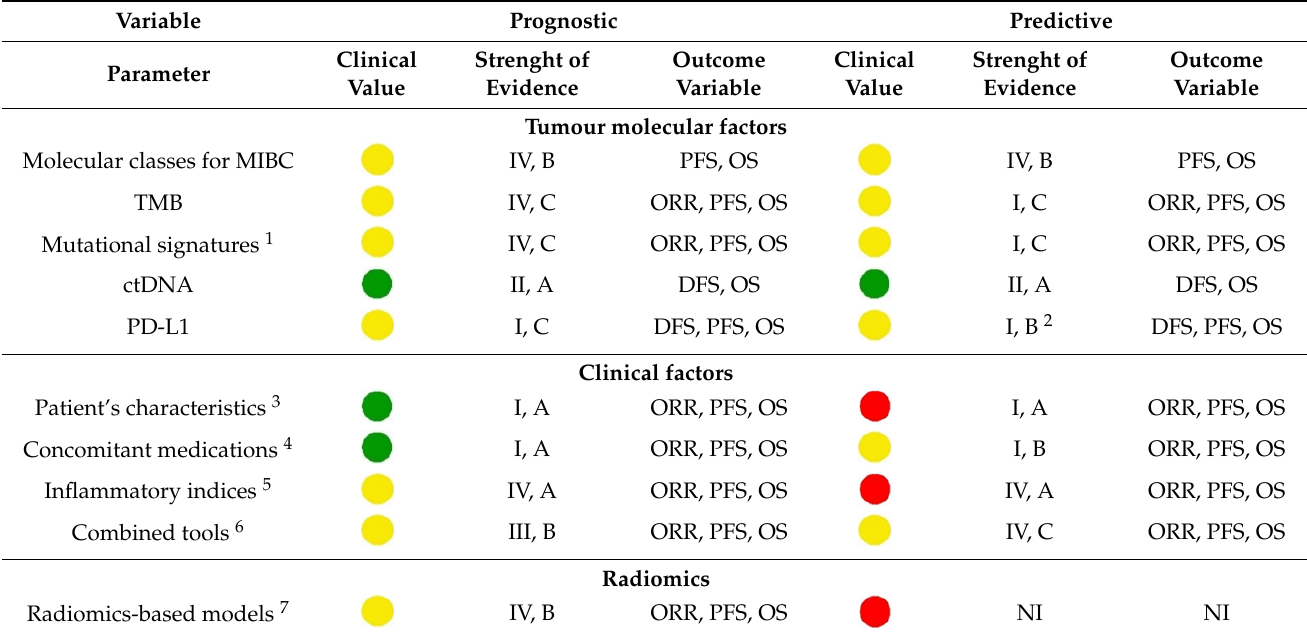
Table 3. Prognostic and predictive values of tumour and clinical factors for their impact on the response and survival outcomes in mUC treated with ICIs. PFS, progress-free survival; OS, overall survival; ORR, overall response rate; DFS, disease-free survival; NI, not investi- gated. 1 DNA and RNA signatures such as the APOBEC, TGFbeta, IFN-γ and IFN-alpha; immune-related signatures such